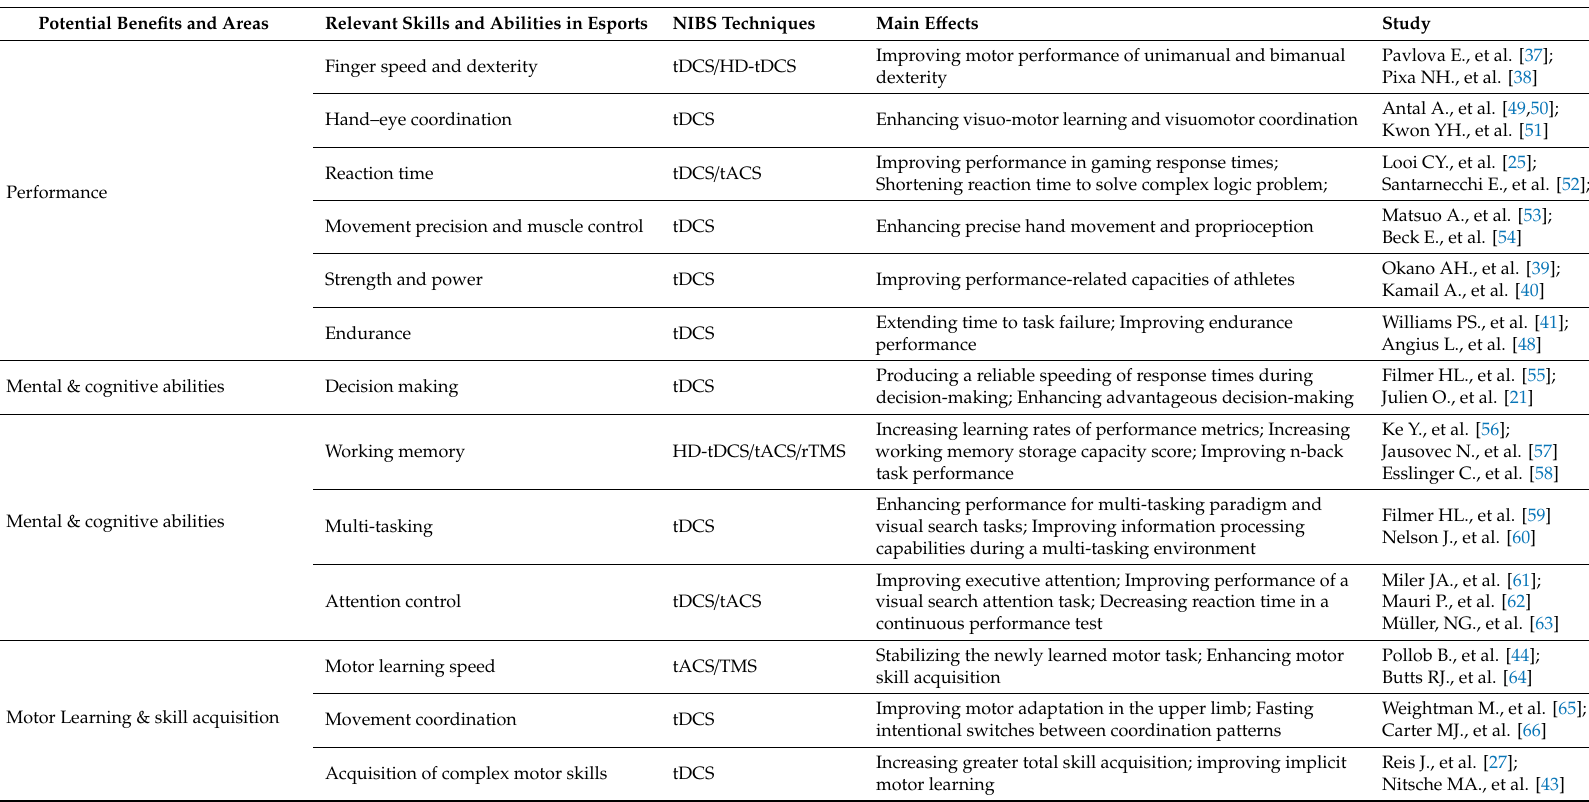
Table 2. A summary of studies for the potential benefits and areas of non-invasive brain stimulation (NIBS) applications in